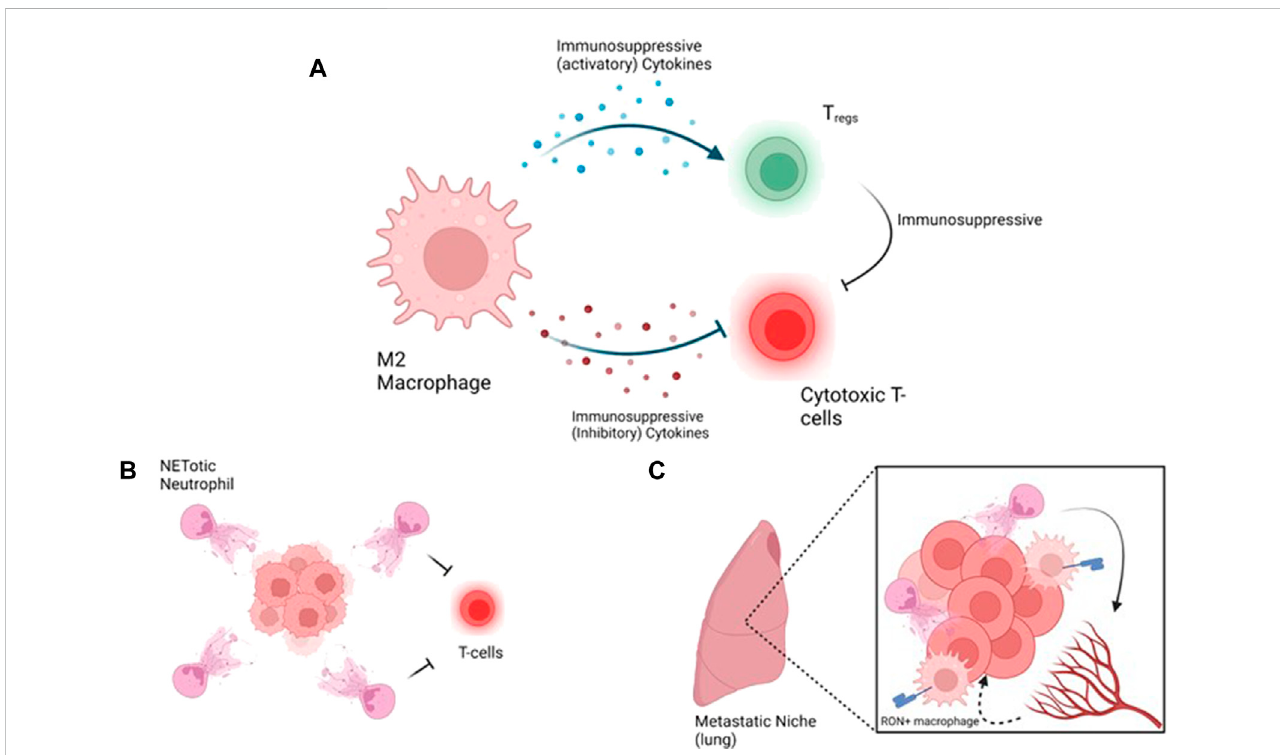
FIGURE 4 Strategiestargetingimmunehottumorsandmetastasis, (A) AloopbetweenmacrophagespromotesimmunosuppressionbyactivatinginhibitoryT-cells such as Tregs and inhibition of cytotoxic T-cells. Inhibitory T-cells emphasize the suppression of cytotoxic T-cells, (B) At the primary tumor site, NETotic neutrophilsprotectthetumorsfromcytotoxicT-cells, (C) Atthemetastaticsite,neutrophilspromotevascularpermeabilitytoallowextravasyionofthetumor cells and macrophages support the immunosuppressive environment via MSP/RON. Figure generated with